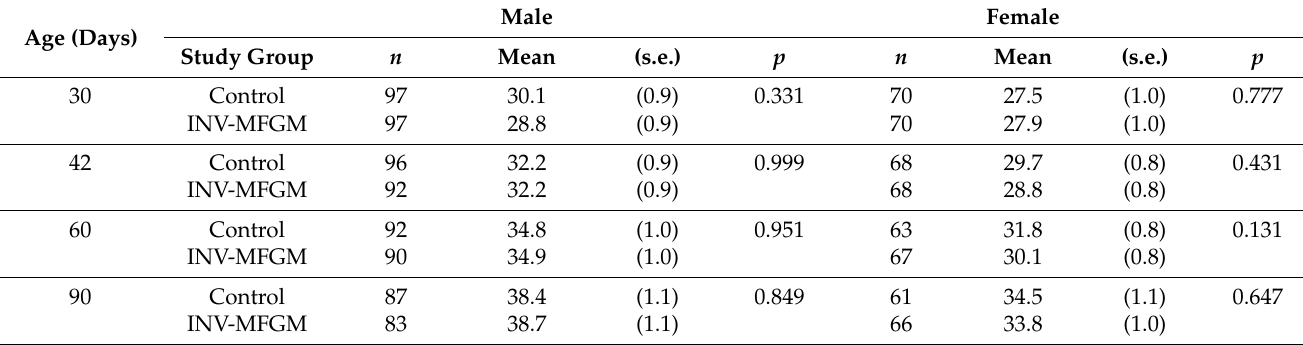
Table 4. Study formula intake (fluid oz/day) at days 30, 42, 60, 90, 120, 180, 275, and 365 *.